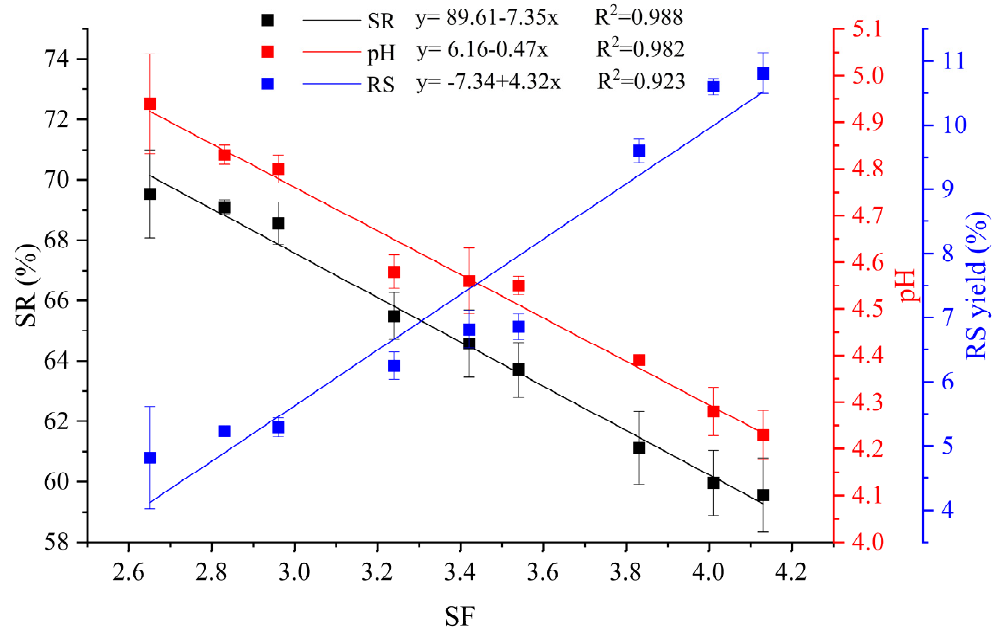
xylose and arabinose were degraded to other byproducts in higher SF, resulting in a lower yield [28,29]. In contrast to the other monosaccharides, the glucose yield in the control groups was higher than that after HTE with significant difference ( p < 0.05). The result may be because part of the glucose released from the BW itself was degraded during the HTE, while the amount of glucose produced by the degradation of cellulose and hemicellulose in the HTE was less than the degraded during HTE [28]. In the HTE groups, the tendency was similar to those of xylose and arabinose, with maximum yields of 1.81 ± 0.01%, obtained at 160 ◦ C for 30 min (SF = 3.24).